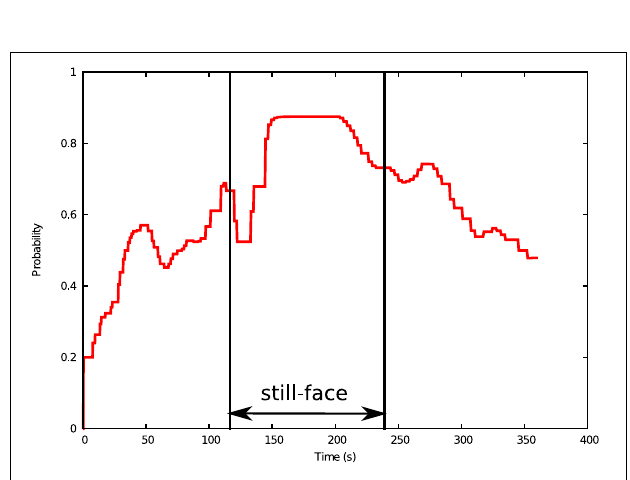
FIGURE 9 | Probability of agent action as a function of time in the simulated still-face